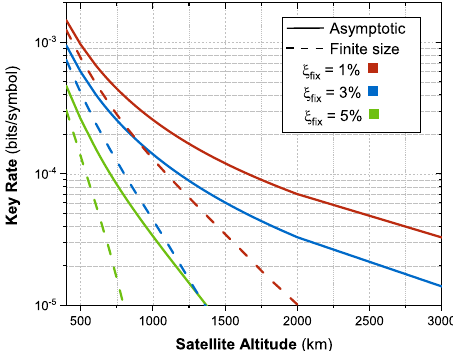
Fig. 9 Impact of the electronic noise on key rate. Comparison of secret key rate for two different electronic noise ν el and three different excess noise values.